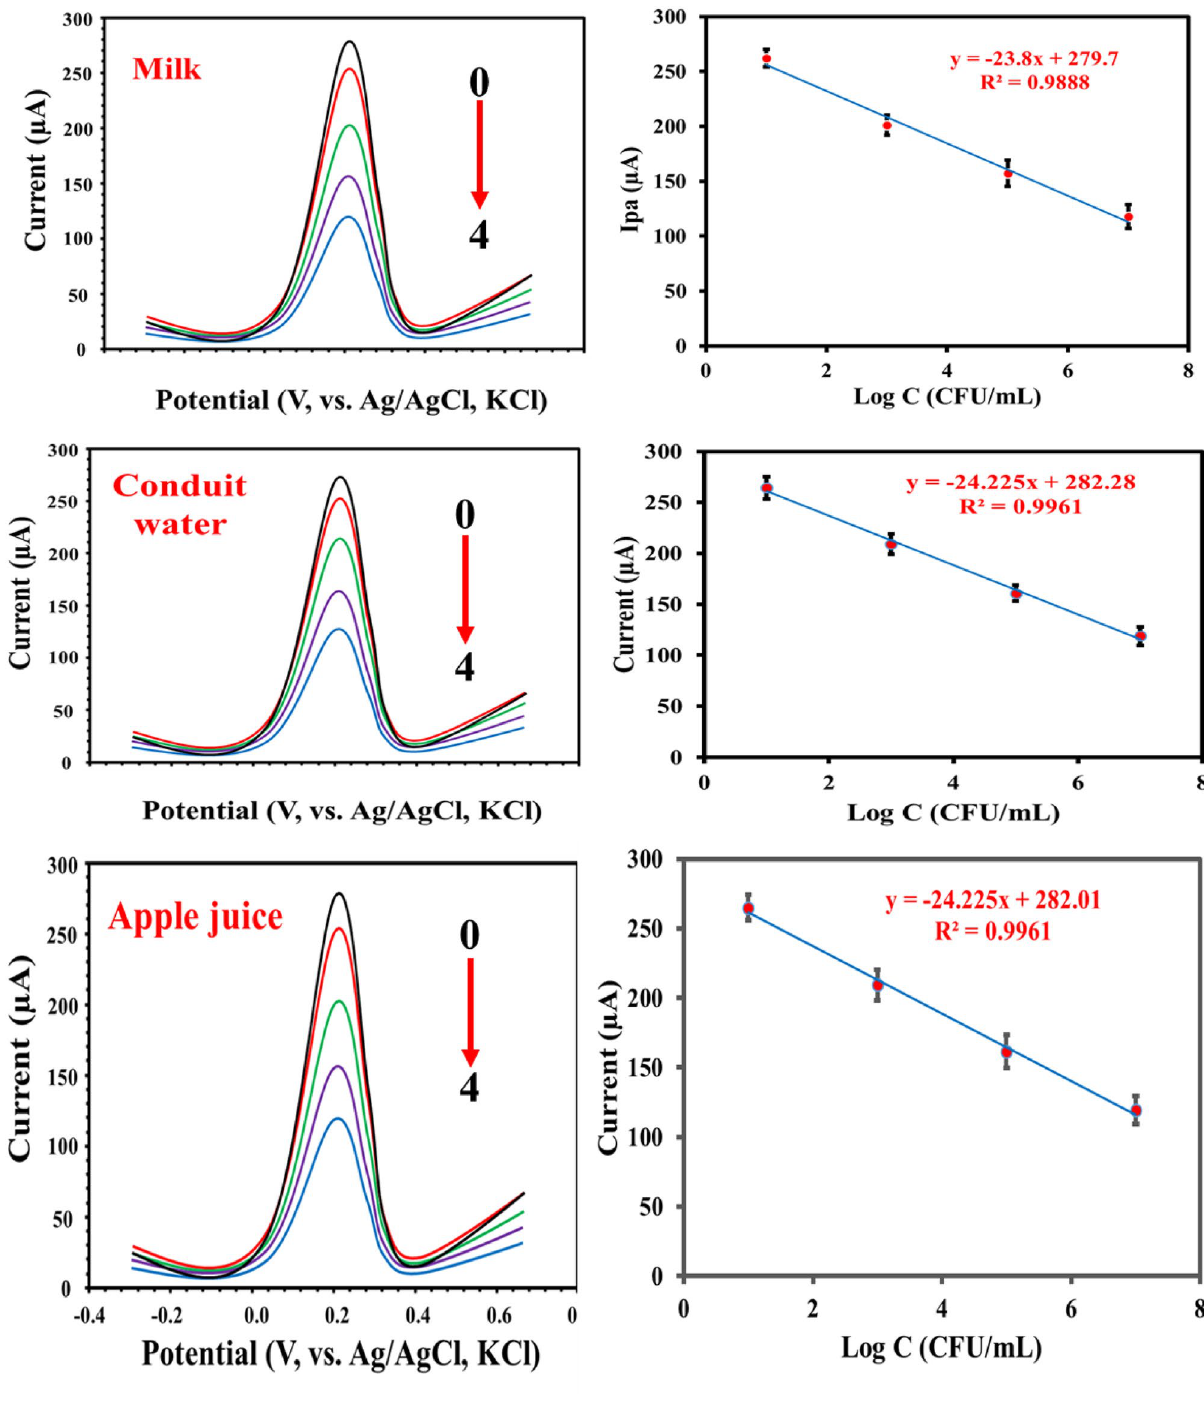
Figure 6. DPVs of MIP-apt-AuNPs@ Fe 3 O 4 /GCE after incubation with different concentrations of the S. aureus (0:0, 1:10 1 , 2:10 3 , 4:10 5 , and 4: 10 7 CFU·mL −1 S. aureus in milk, conduit water, and apple juice samples. Conditions are concentration of [Fe(CN) 6 ] 3−/4− = 5.0 mM, pulse height of 30 mV, pulse width of 0.08 s, and step height of 15